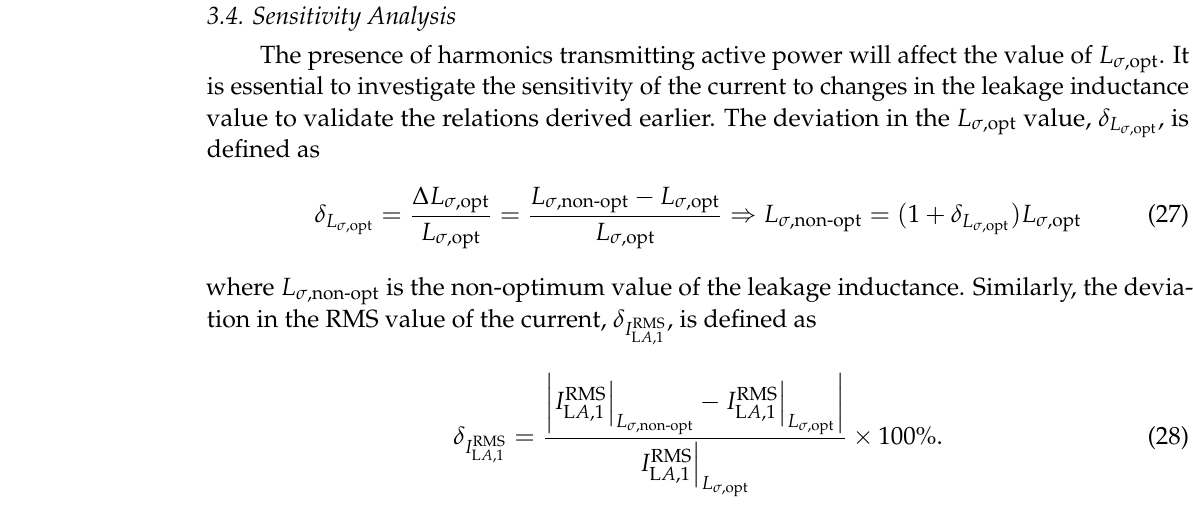
Figure 7. Optimum leakage inductance calculation